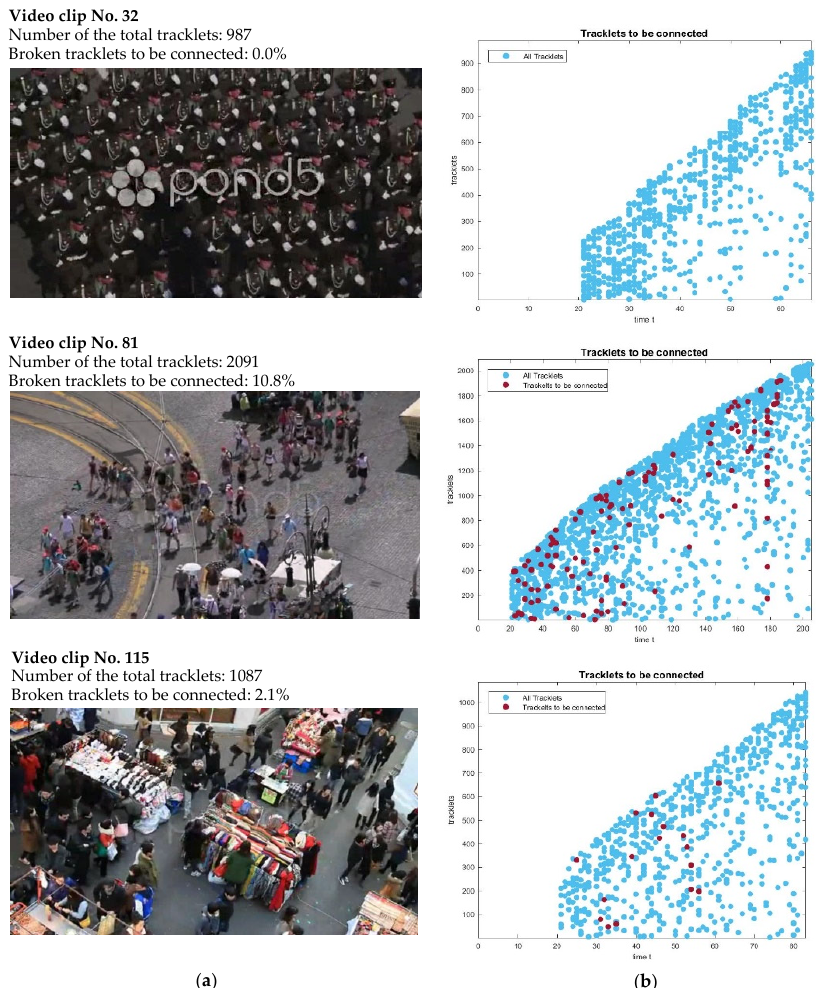
Figure 6. Selected examples from CUHK crowd dataset. ( a ) Video clips scene. ( b ) Plot of raw KLT tracklets in blue color dots during video lifetime. The disconnected KLT tracklets (which are the tracklet candidates to be connected) are represented in red color dots.